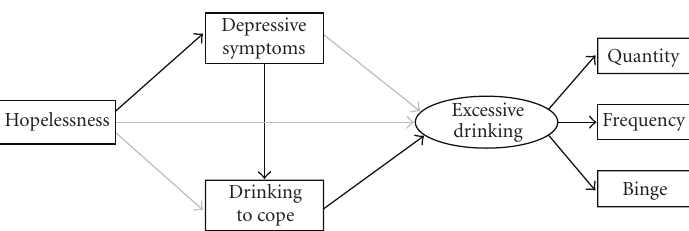
Figure 1: The hypothesized structural model. Rectangles represent manifest variables; ovals represent latent variables. Black arrows represent hypothesized direct e ff ects; grey arrows represent paths hypothesized to be explained by indirect e ff ects. Quantity = drinking quantity; Frequency = drinking frequency; Binge = binge